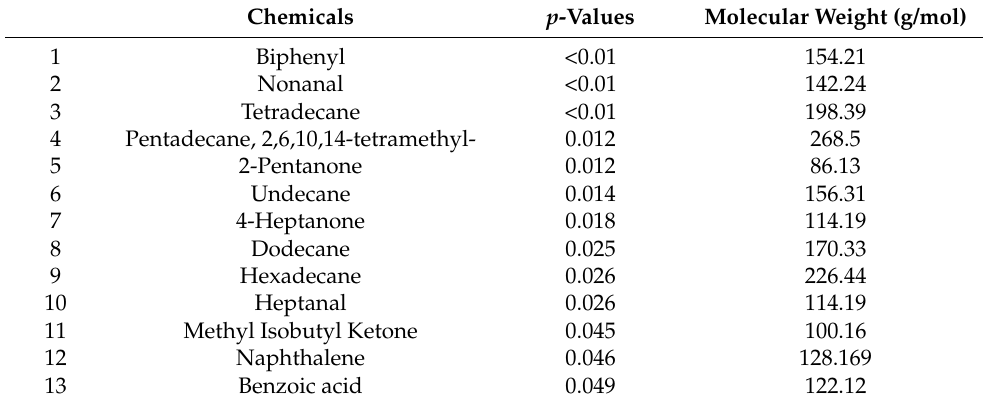
Table 4. A list of possible biomarkers from the analysis of urine samples by GC-TOF-MS identified using PubChem, NIST and publications significant to bladder cancer.